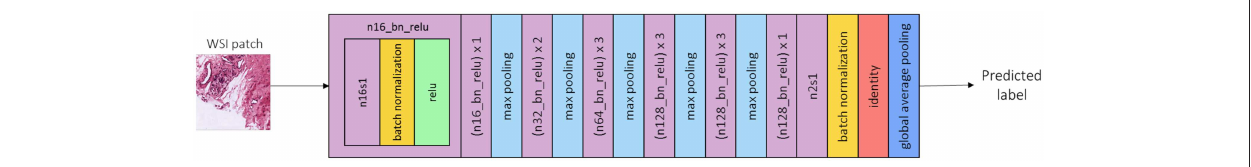
FIGURE 9 | CNN architecture overview. A convolution layer with 16 3 × 3 filters, and a stride of 1 × 1 is denoted by n16s1 . The same, followed by a batch normalization layer (yellow) and a ReLU non-linearity (green) is denoted by n16_bn_relu . The learning rate used for training is 0.0001, the optimizer is SGD with momentum 0.9 and the batch size is set to 16.